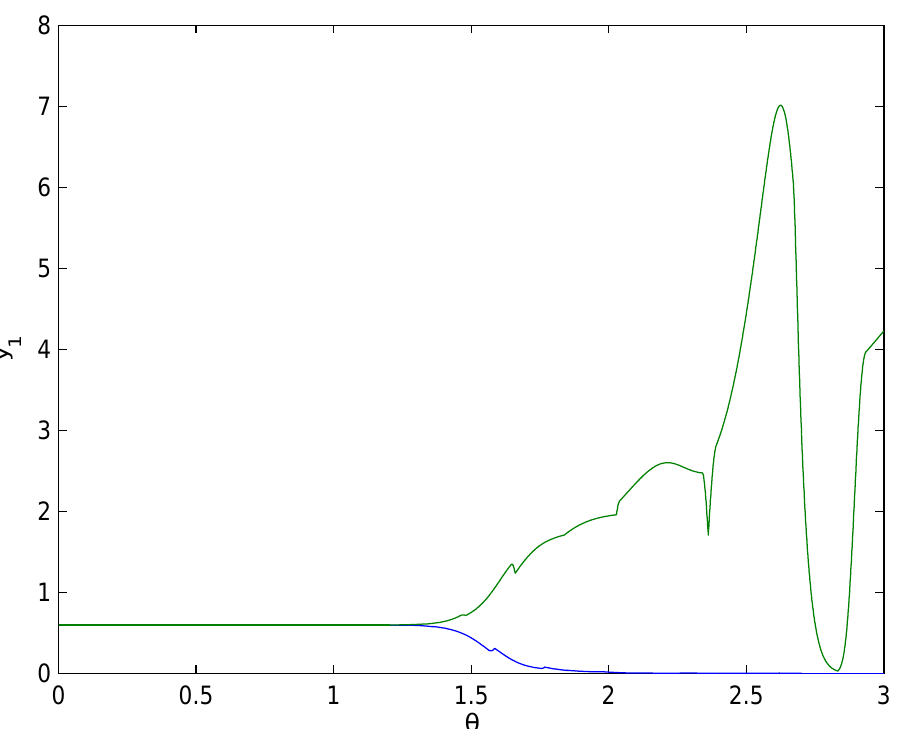
Figure 7. Bifurcation figure of model (63): the relation of t and y 1 . The bifurcation value is approxi- mately equal to 1.33.